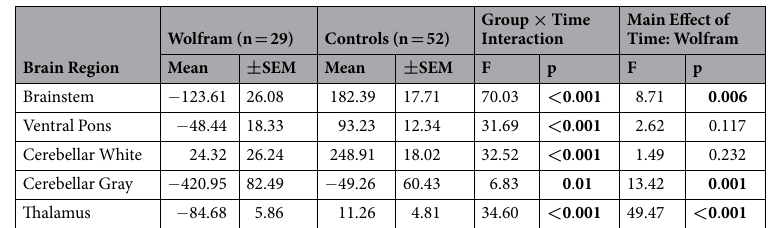
Table 2. Mixed model results for regions of interest. Mean and standard error of the mean (SEM) of the estimated annual rates of change are shown for each region and group. F and p values for each region come from the interaction of group by time, controlling for age, sex, and diabetes, and the main effect of time within the Wolfram group, controlling for age and sex. Significant results at the p ≤ 0.01 level are in